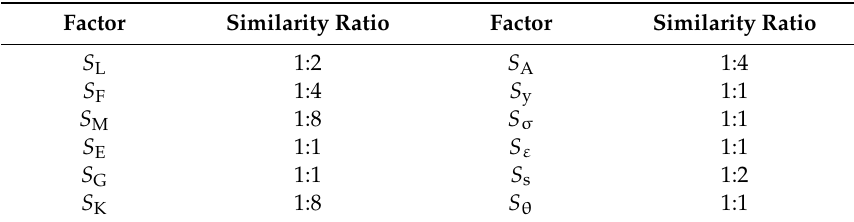
Table 3. Similarity ratio of each